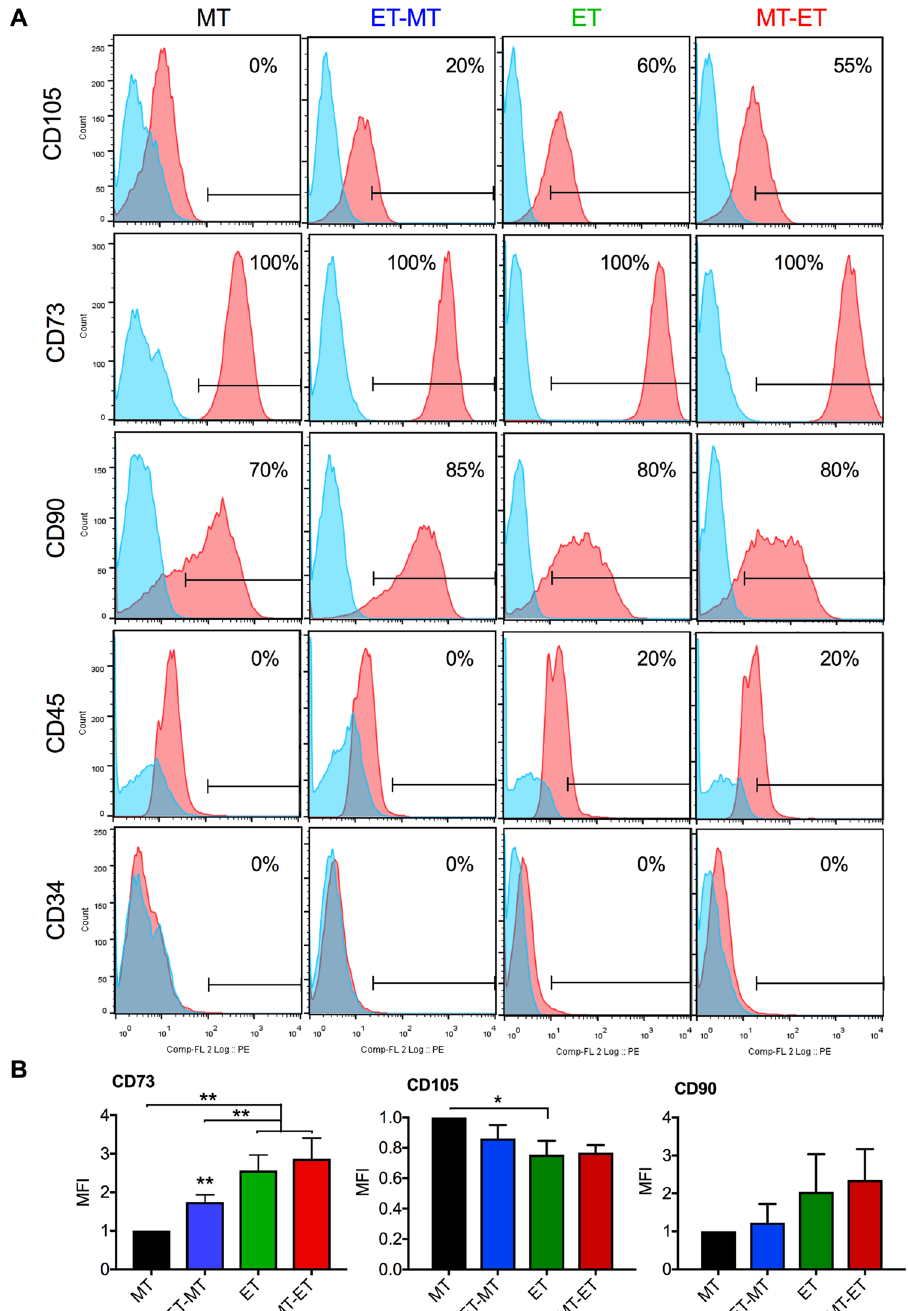
Figure 2. Immunophenotype of RS-hAFSCs cultured under different conditions. ( A ) Flow cytometry to show levels of expression of CD105, CD73, CD90, CD45 and CD34. Isotype control in blue. ( B ) Relative mean fluorescence intensity (MFI) for the different groups (measured from 10,000 cells and using the same antibody concentration, experimental conditions and cytometer settings for all groups). Data represent mean ± SEM. SEM: standard error of the mean. ** P <